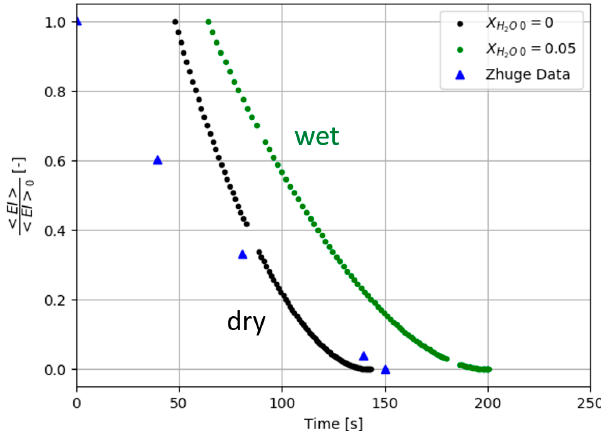
Figure 14. Post-combustion time dependence of the normalized flexural modulus for a degradation rate of 50%. Comparison of numerical simulation prediction as a function of combustion time between pure thermal and hygro-thermal models for an E-glass / polyester composite laminate and a heat flux of 50 kW/m 2 . Experimental data ( ▲, dry material ) obtained by Zhuge et al. [25] are also reported.